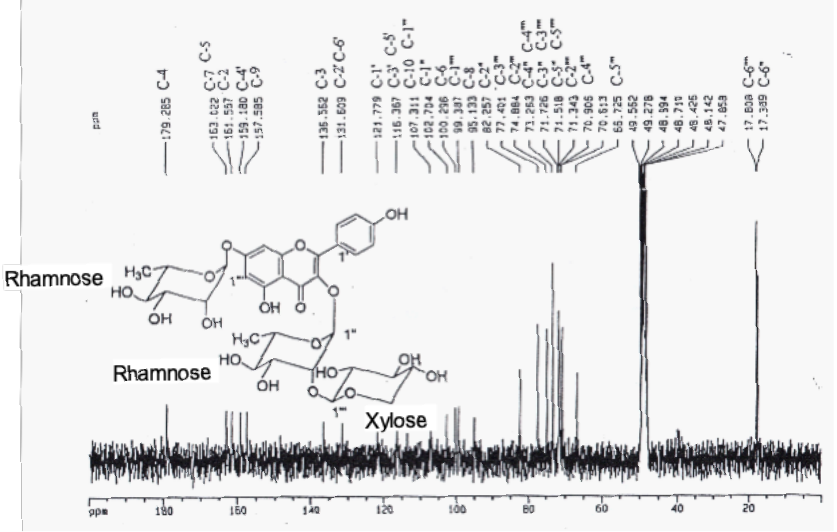
Figure S4: 13 C-NMR spectrum of sagittatin A (75 MHz; CD 3